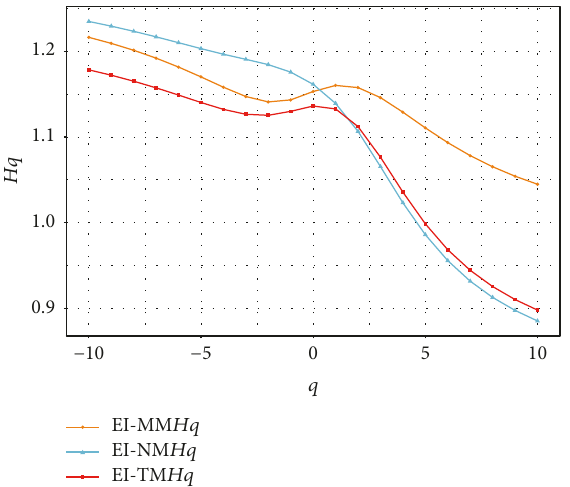
Figure 14: Scaling exponents between cross-correlation exponent for 𝑞 = 2 for news and return and market inefficiency